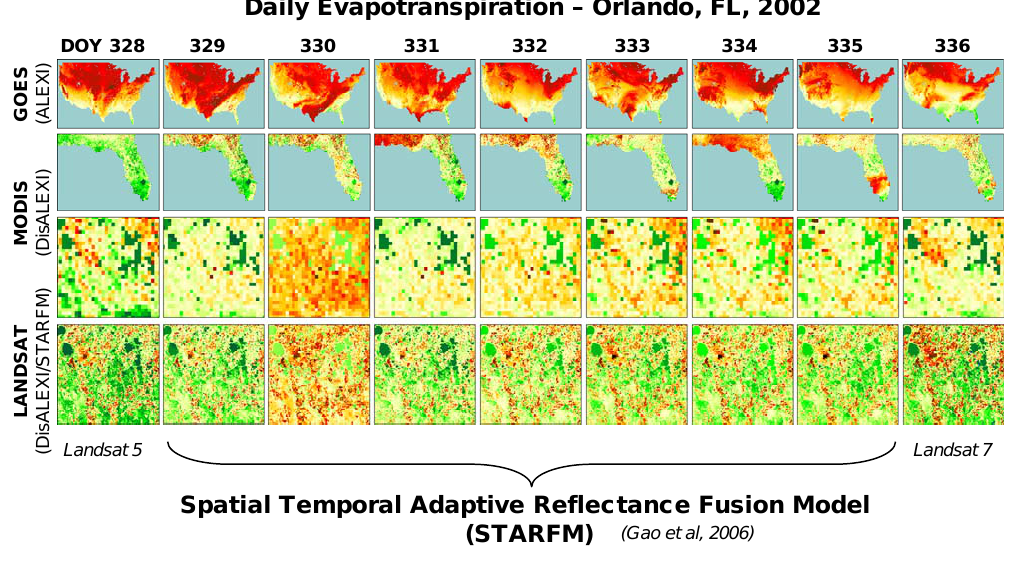
Fig. 4. Example of Landsat/MODIS/GOES ET data fusion, showing maps of daily ET from ALEXI at 10-km resolution (top row), at from DisALEXI using MODIS TIR at 1-km resolution (middle rows), and from the STARFM data fusion algorithm, fusing information from DisALEXI using Landsat TIR sharpened to 30-m resolution (bottom